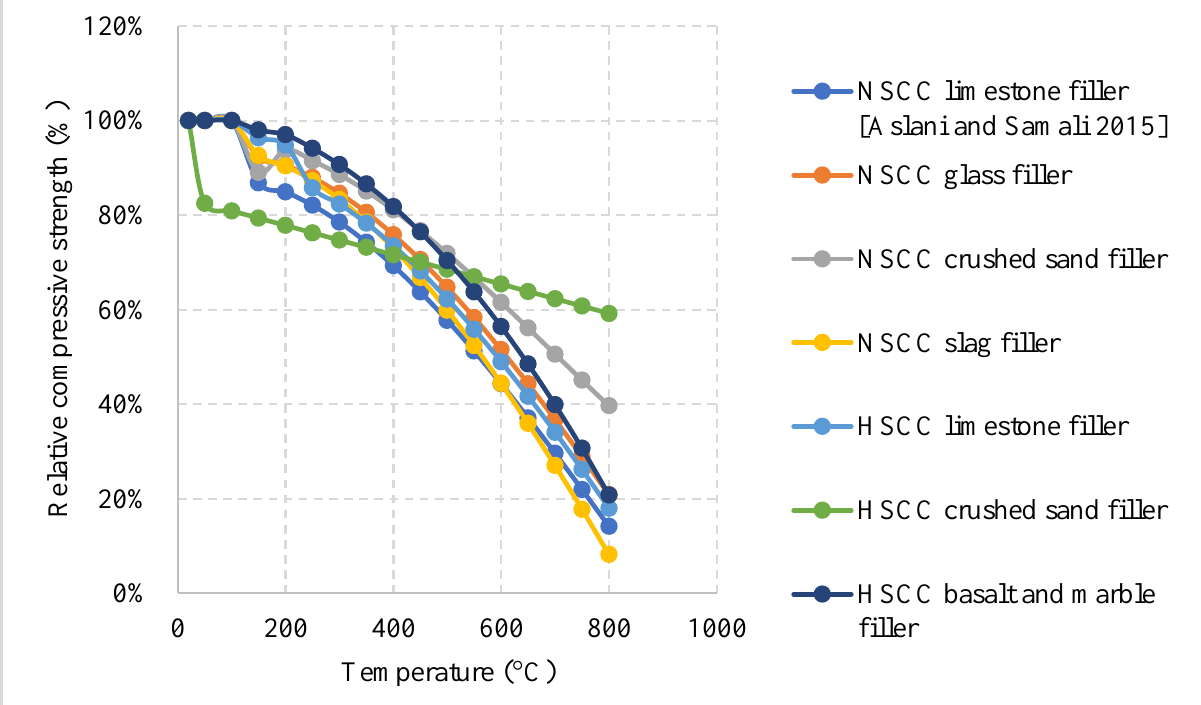
Figure 49. Relative compressive strength models for different types of concrete 2 [100].